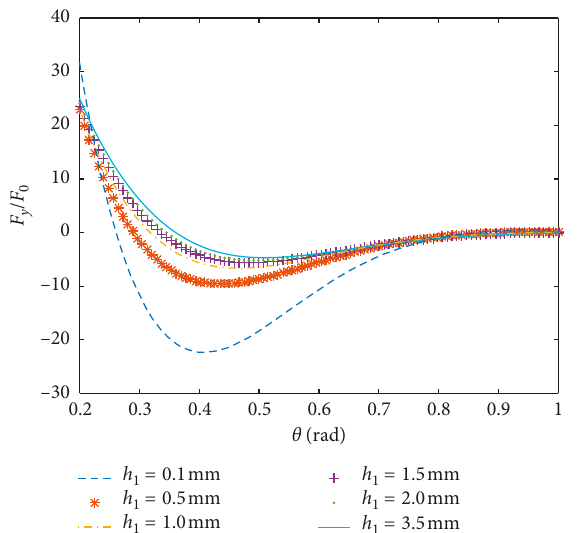
x and angle θ for . 1